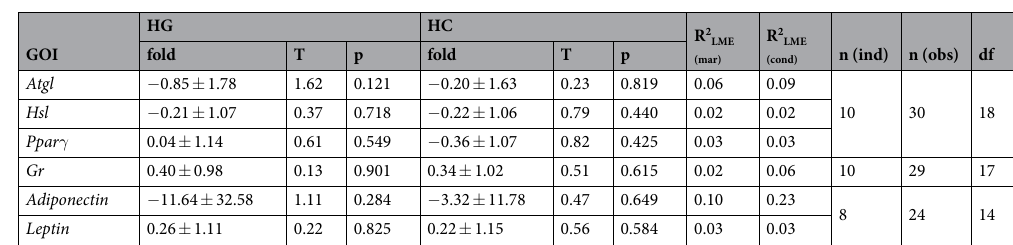
Table 3. Mean ( ± S.D) fold difference in relative mRNA abundance of each gene of interest (GOI) relative to the control (5.5 mM glucose) condition. Blubber explants derived from biopsy cores from adult grey seals (n = 10) were divided into 100 mg portions of tissue and exposed to 5.5 mM glucose (control); high glucose (HG: 25 mM) or high hydrocortisone (500 nM + 5 mM glucose: HC) overnight and harvested by snap freezing the following day. GOI Ct values were divided by the geometric mean of two non-regulated reference genes ( CycA and S9 ) and log transformed. The effect of treatment on each GOI was investigated in an LME, with individual as a random effect. T, p, and marginal (mar) and conditional (cond) R 2 LME ; n (individuals); n (observations) and degrees of freedom (df) are given for each gene of interest. Where n (individuals) is less than 10 there was insufficient RNA to run all GOI. Atgl = adipose triglyceride lipase ; Hsl = hormone sensitive lipase ; Ppar γ = peroxisome proliferator activated receptor γ ; Gr = glucocorticoid receptor